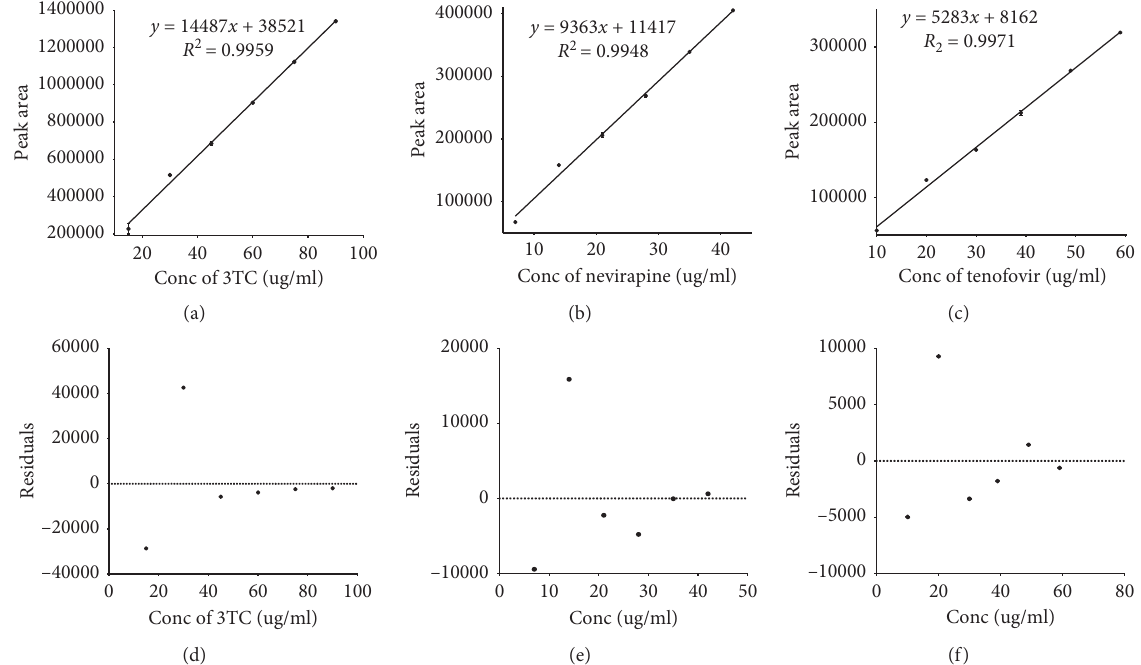
1 , (b) B 1 , (c) C 1 , (d) A 2 , (e) B 2 , and (f) C 2